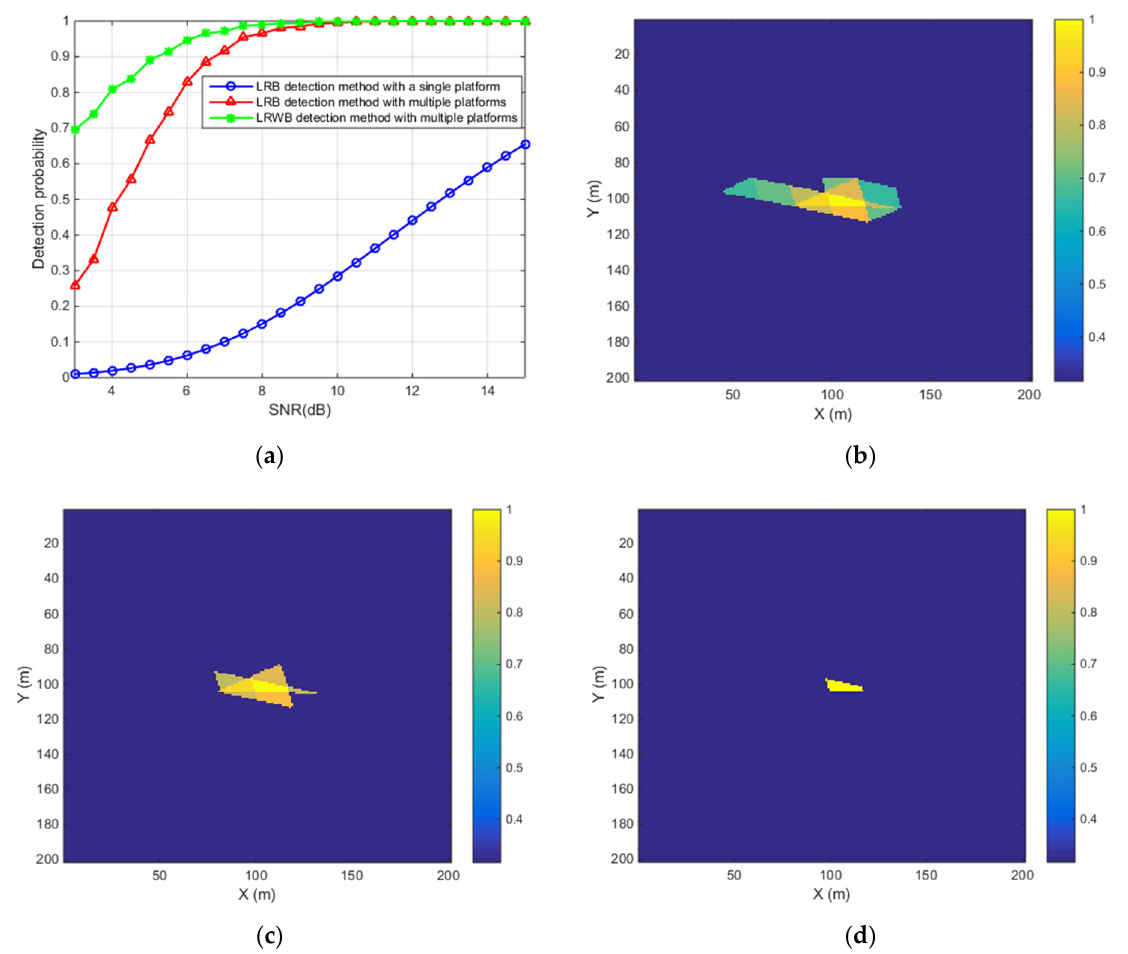
Figure 11. Detection performance analysis. ( a ) The detection probability with different methods; ( b ) The detection result using LRB detection method with a single platform; ( c ) The detection result using LRB detection method with multiple platforms; ( d ) The detection result using LRWB detection method with multiple platforms.